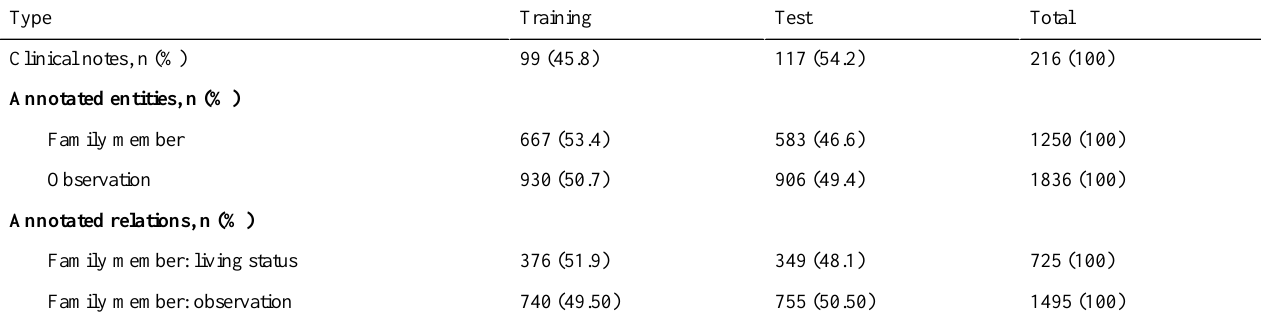
Table 1. Detailed data set statistics. TotalTestTrainingType